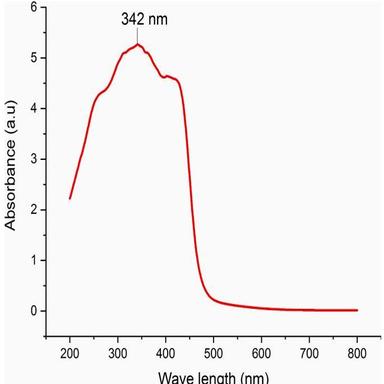
UV-Vis-NIR SPECTRUM OF CDMBP